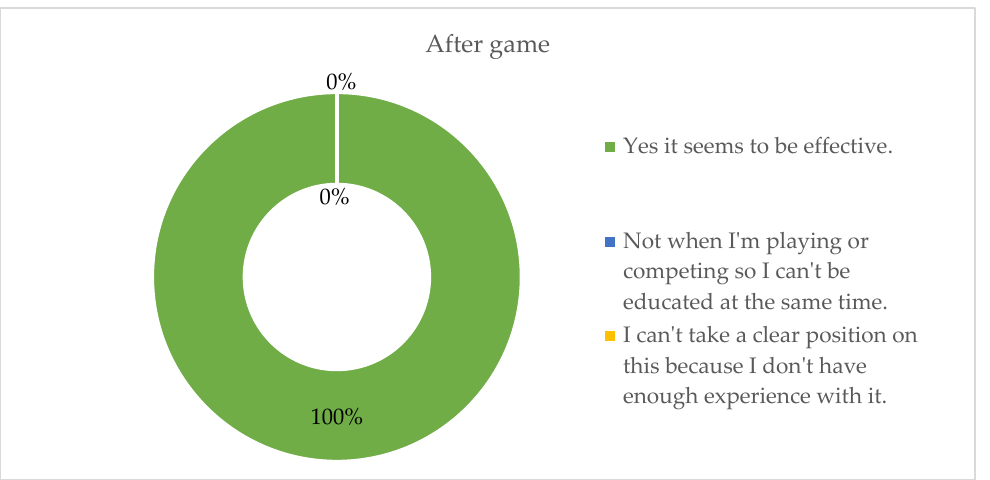
Figure 5. Results of questionnaire for question: Is it effective to educate in the form of a competition or a game? (before using toolkit).